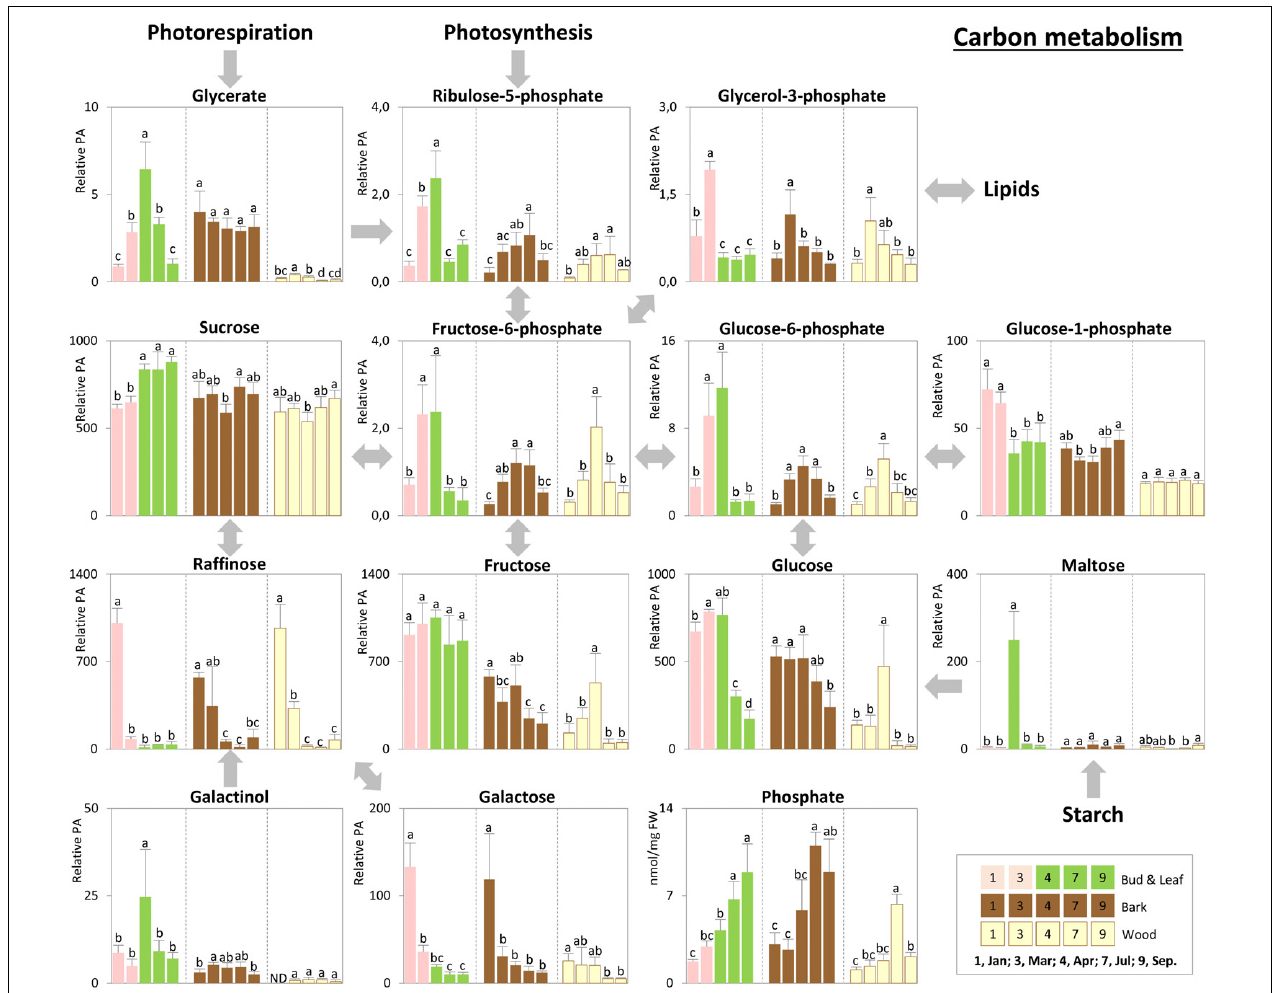
FIGURE 4 | Metabolic changes in carbon metabolism. Changes of the selected metabolites in carbon metabolism in poplar during annual growth. Data represent mean values of five biological replicates in each organ/tissue for each season. Error bars represent SD. Different letters represent statistically significant differences ( P < 0.05) between seasons in each organ/tissue using Tukey’s test ( Supplementary Table S1 ). Relative PA, relative peak area; ND, under detection